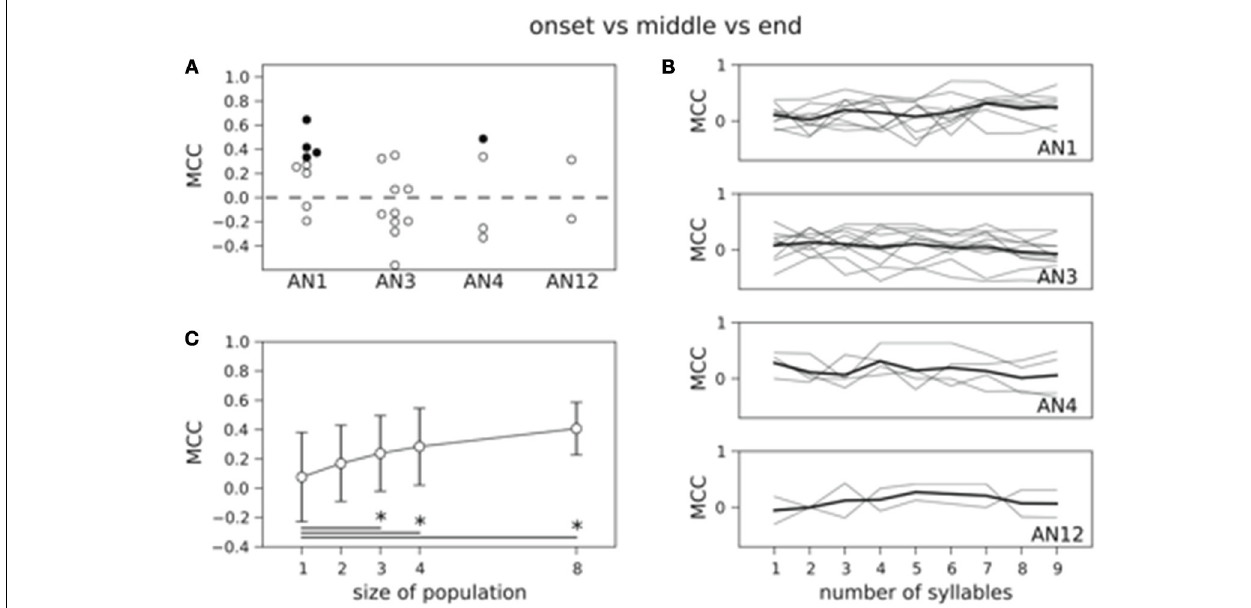
FIGURE 5 | Count based decoding of the three perturbed stimuli in single neurons and populations. (A) Only in 5 neurons the three perturbed stimuli are decoded significantly better than a classification based on randomized counts. The distribution of MCC values of all 25 classifiers does not differ significantly from the MCC distribution of the classifiers that are based on randomized counts ( p = 0 . 23, one-sided Wilcoxon rank-sum test). Dashed line represents chance level.